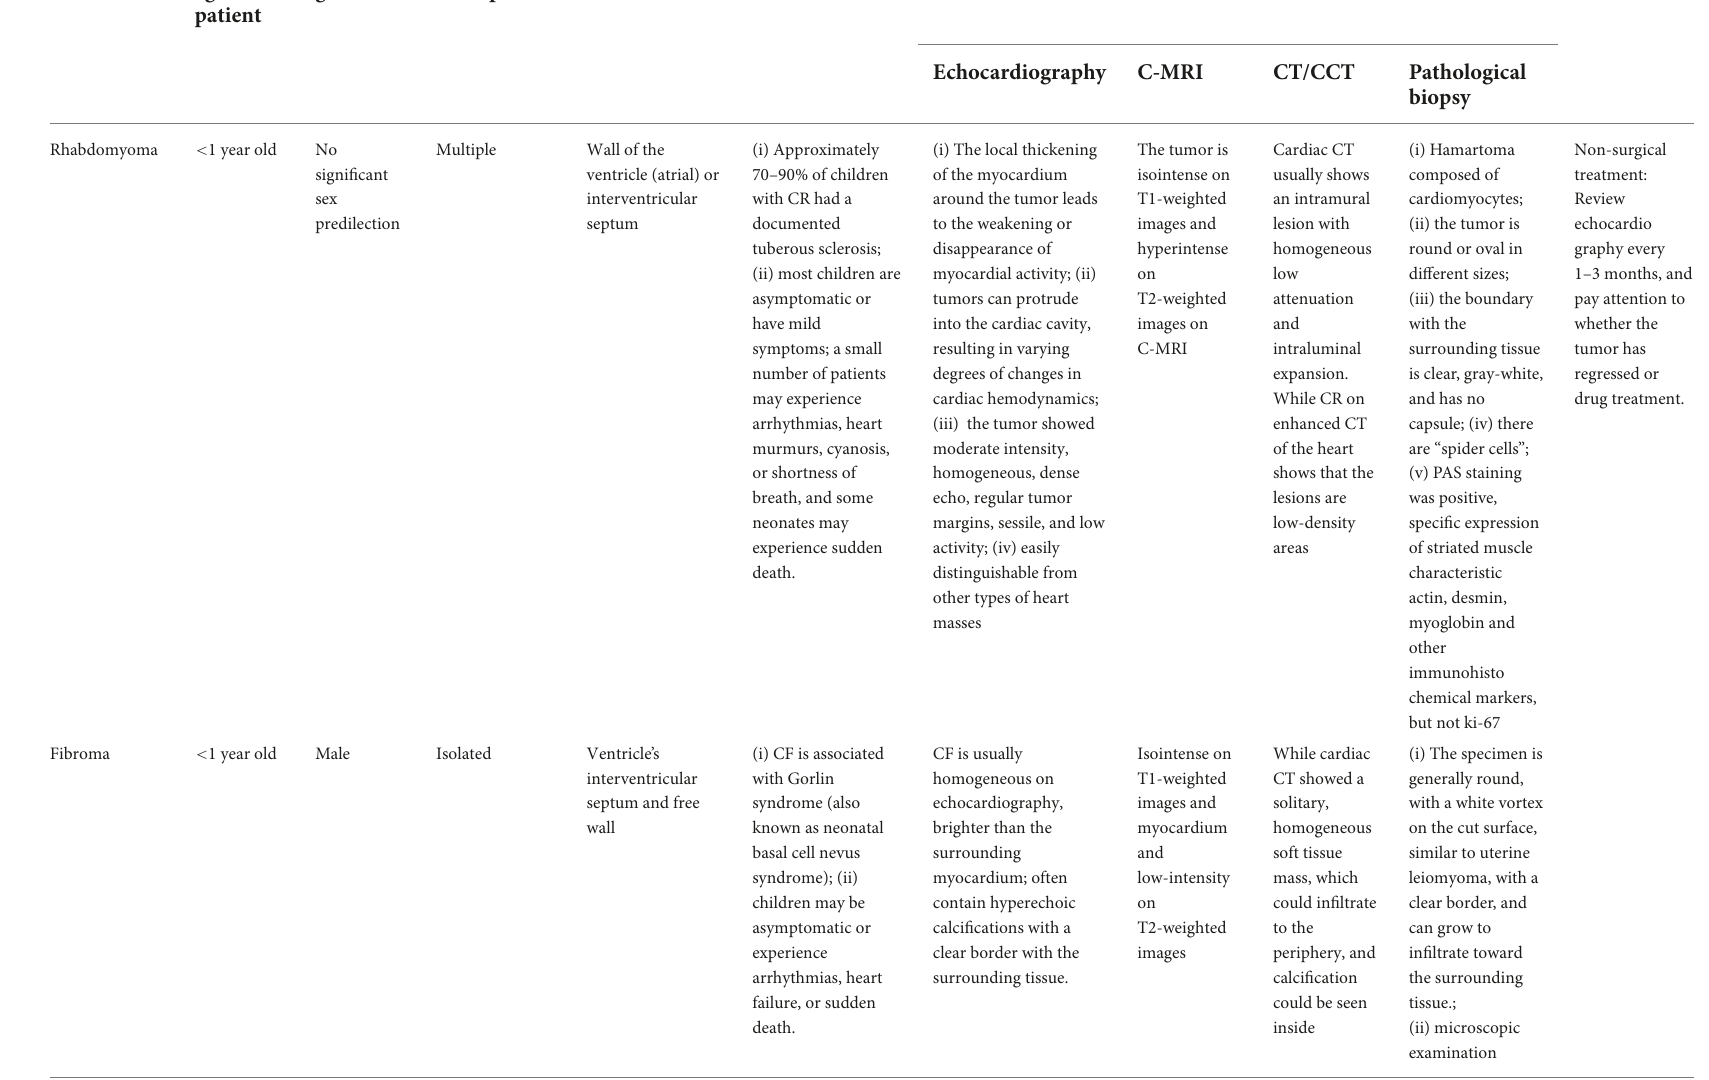
TABLE 2 Characteristics, imaging results, and treatment options of different benign cardiac